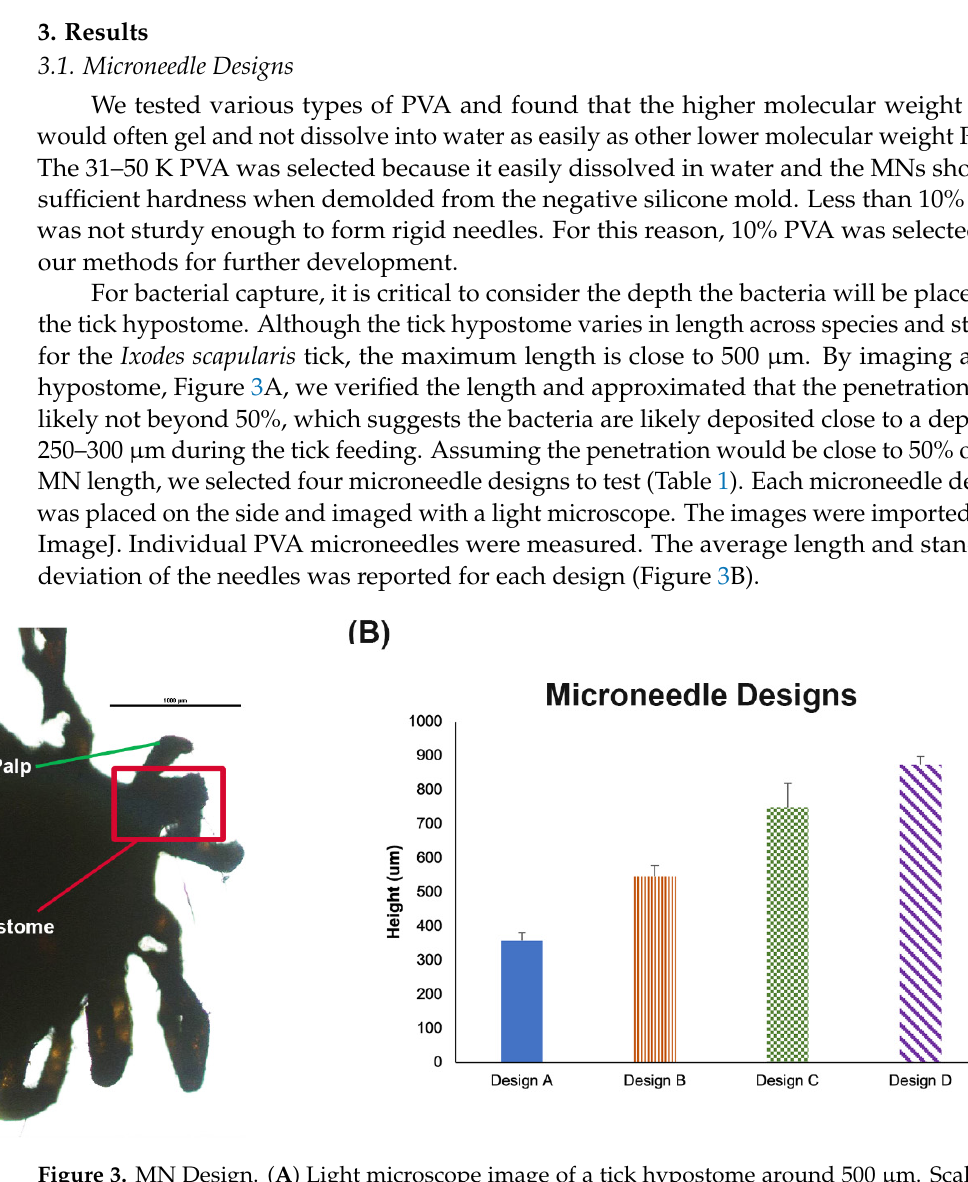
Figure 3. MN Design. ( A ) Light microscope image of a tick hypostome around 500 μ m. Scale bar 1000 μ m. ( B ) Measured height for each PVA MN design from Table 1 with four needles per patch (n = 3) ± SD.